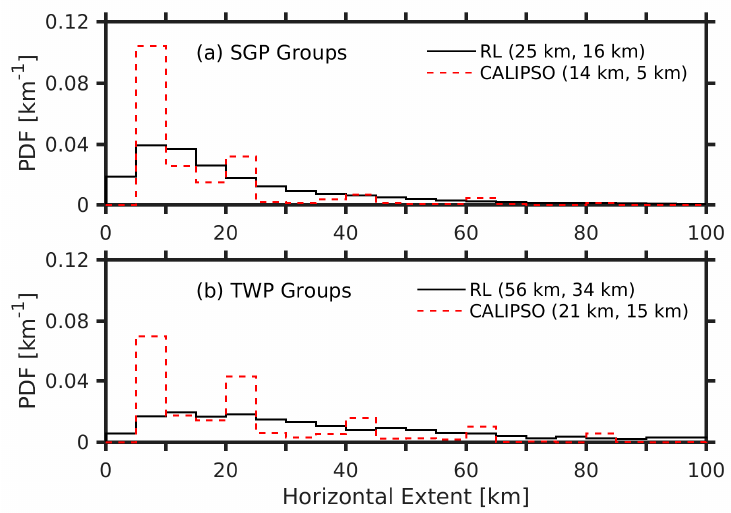
Figure 6. Probability distribution functions (PDFs) of the horizontal extent for groups of continuous transparent ice cloud profiles of ice cloud column optical depths below 0.01 for the RL (solid black) and CALIPSO (dashed red) over the ( a ) SGP and ( b ) TWP sites. Mean and median values are given in the parentheses. Data for the RL at the SGP site are from August 2008 to August 2016 and at the TWP site from December 2010 to January 2015. Data for CALIPSO for both the SGP and TWP site are from June 2006 to August 2016.